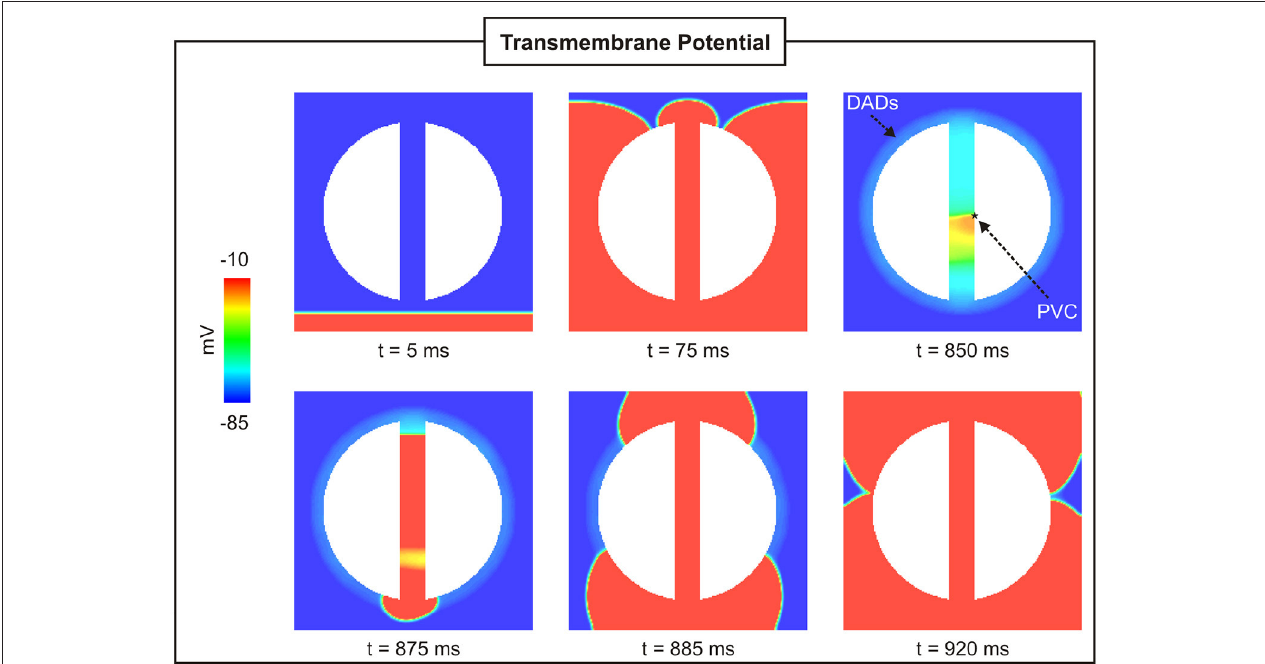
FIGURE 4 | PVC formation in a 2D sheet with the isthmus width of 4mm. V m maps at different times showing a paced beat ( t = 5ms) followed by a PVC ( t = 850ms) in the